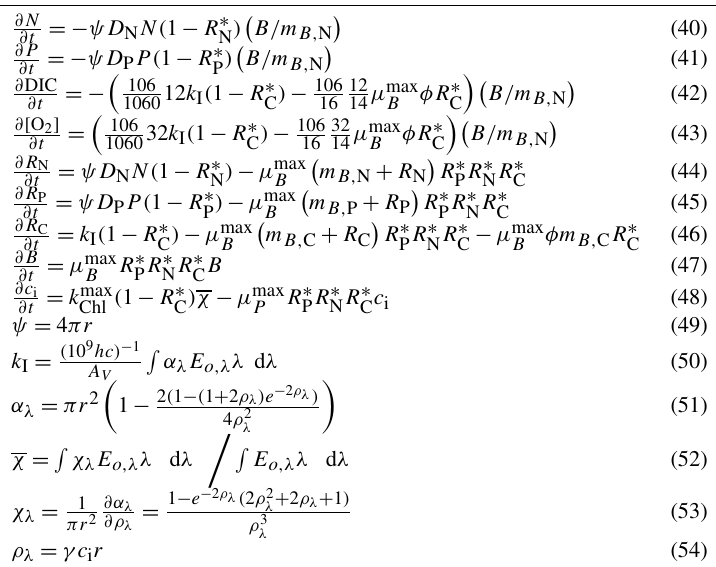
Table 5. Microalgae growth model equations. The term B/m B, N is the concentration of cells. The equation for organic matter formation gives the stoichiometric constants: 12gCmolC − 1 ; 32gOmolO 2 − 1 . The equations are for scalar irradiance specified as an energy